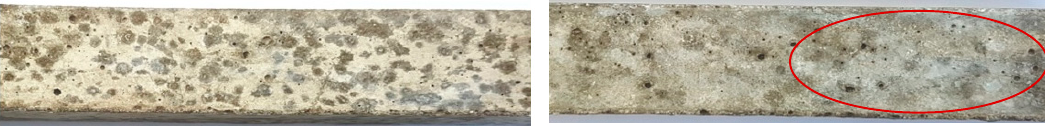
Figure 3. Exudations on the mortar surface ( a ) reference and ( b ) with lithium nitrate. 184